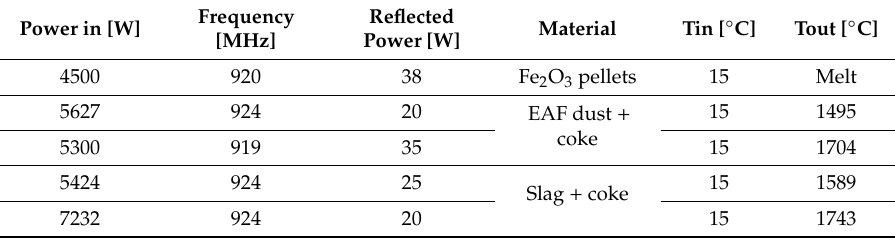
Figure 11. Measured dissipated power on the water load (Experimental) vs simulated one (Model). Table 5. Results of preliminary heating tests ad di ff erent power levels, for 10 min irradiation in case of iron oxides pellets, electric arc furnace dust mixed with 0.7% coke and metallurgical slag mixed to 23% coke. Autotuning o ff